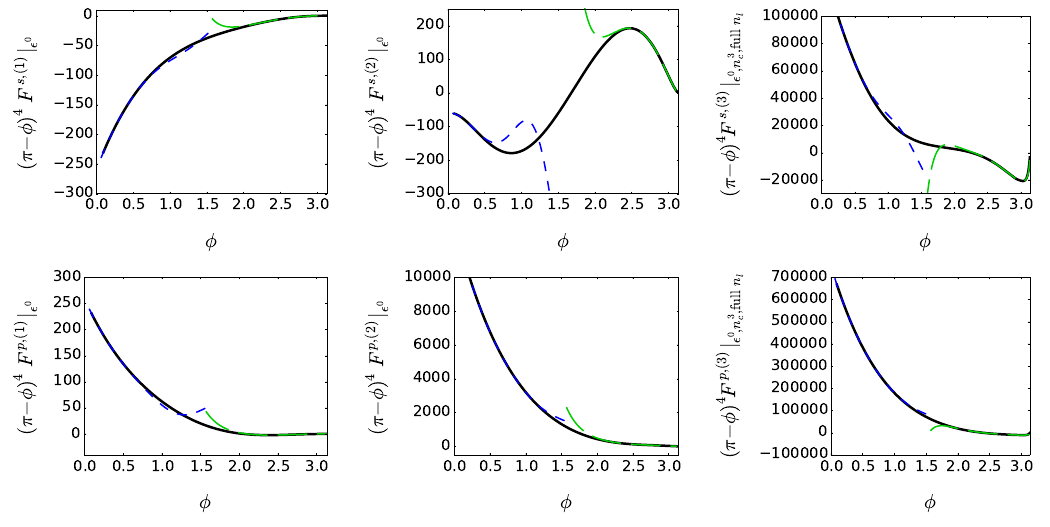
Figure 6 . Same as figure 5 but for the scalar and pseudo-scalar